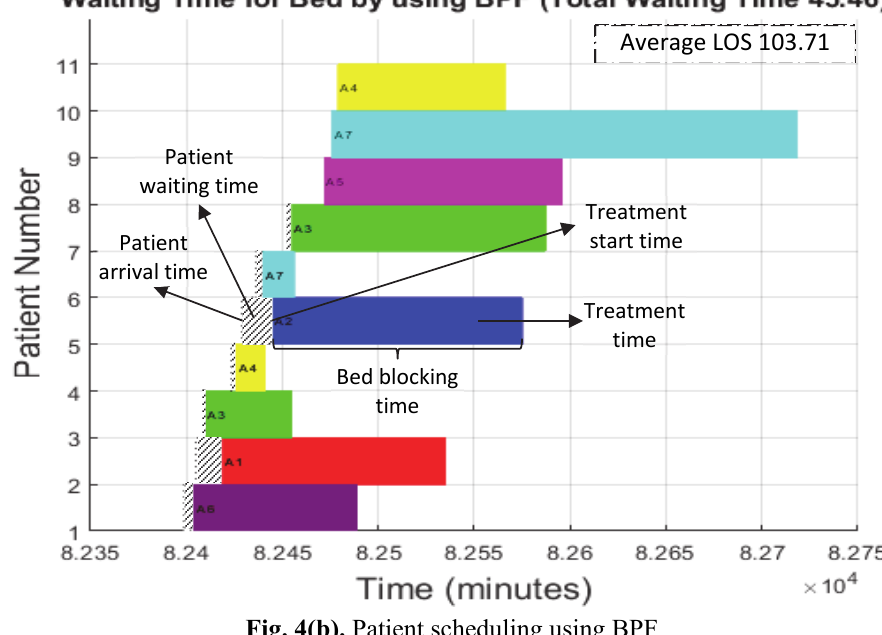
Fig. 4(b). Patient scheduling using BPF Fig. 4. Patient waiting time and bed blocking time using FCFS and